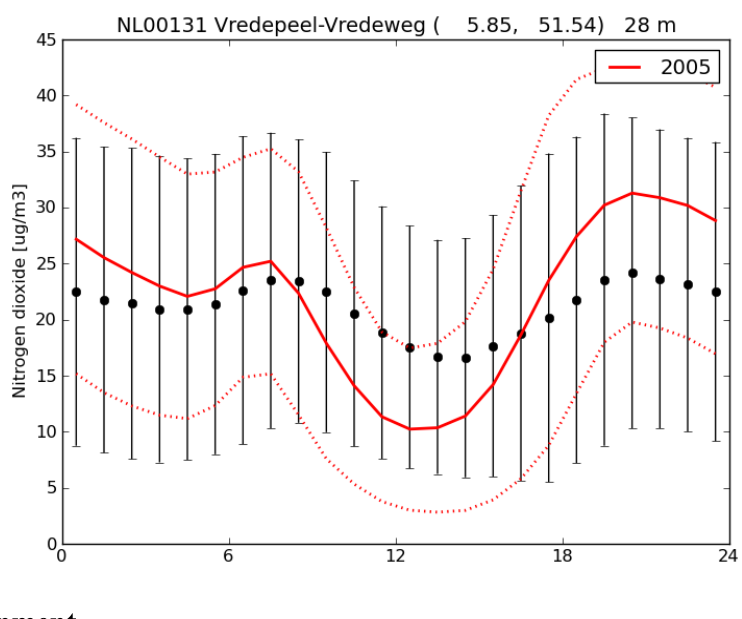
Figure 5. Comparison of observed and modeled diurnal variability for the rural station, Vredepeel, in the Netherlands. Besides the hourly means, also the 2 σ range is given as bars (measurements) and red dotted lines